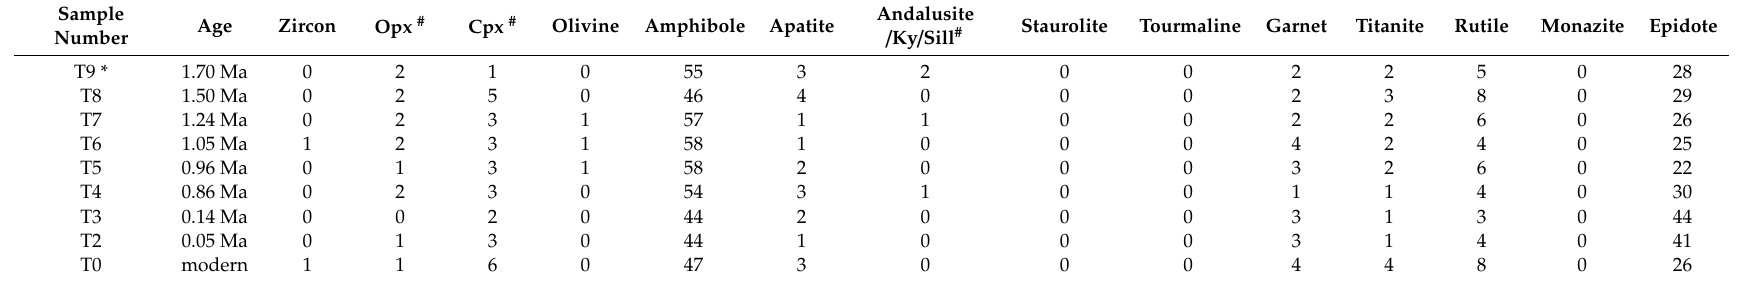
Table 1. Heavy-mineral assemblages in samples from the Yellow River terraces in the Lanzhou area in volume% (data from